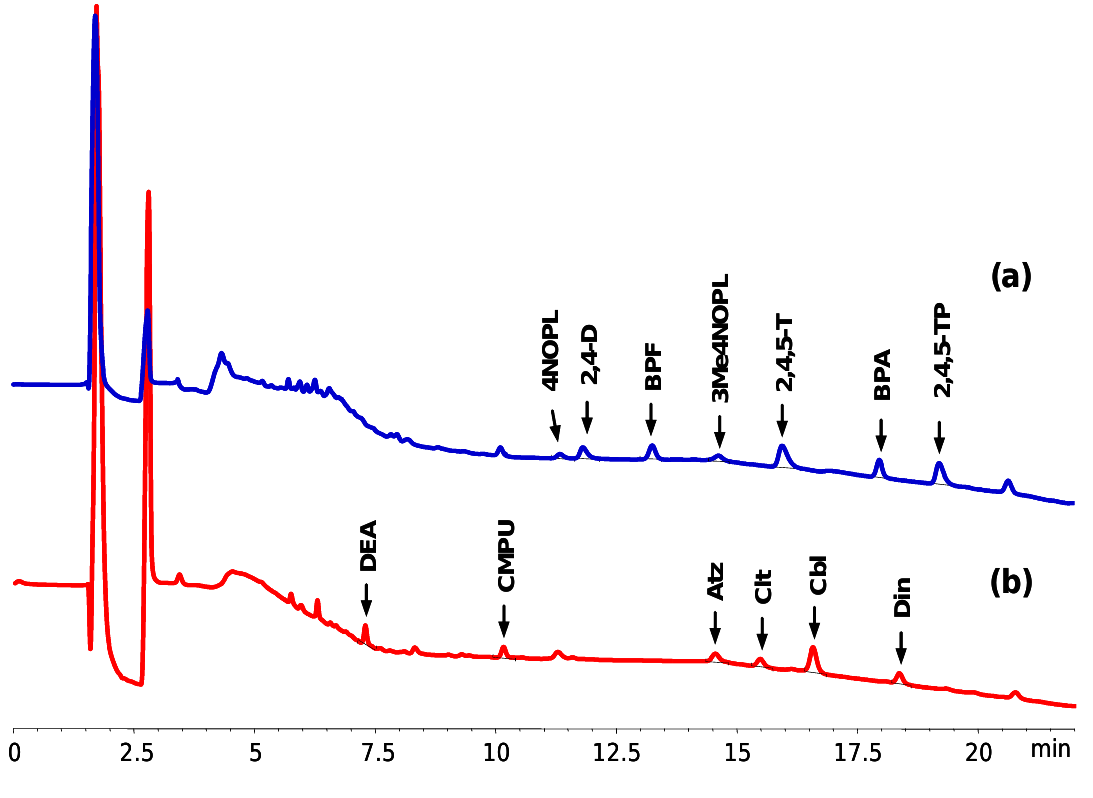
Figure 7. Chromatograms obtained for the MISPE extraction of 100 mL of Tormes river water spiked at a level of 0.5  g L −1 corresponding to the elution step ( a ) and the washing step ( b ). Washing and elution steps as in Figure 6.